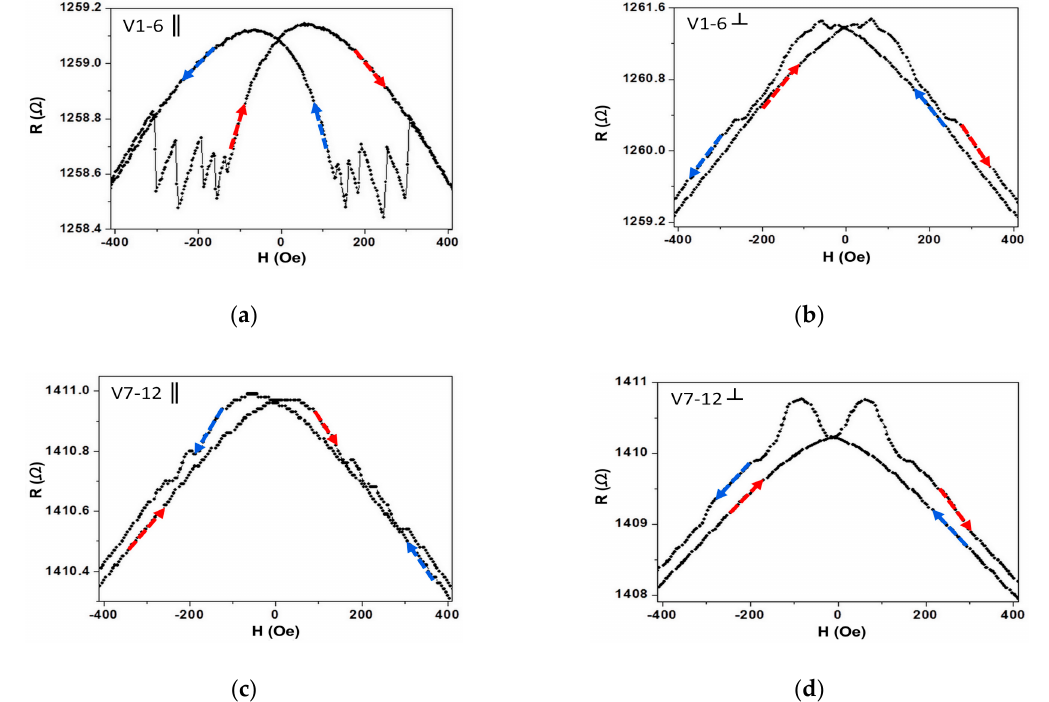
Figure 2. Room temperature magnetoresistance (MR) loops: ( a ) longitudinal and ( b ) transverse MR of middle-contact half-ring wire; ( c ) longitudinal and ( d ) transverse MR of corner-contact half-ring wire. The arrows indicate the direction of the proceeding process on the loop.